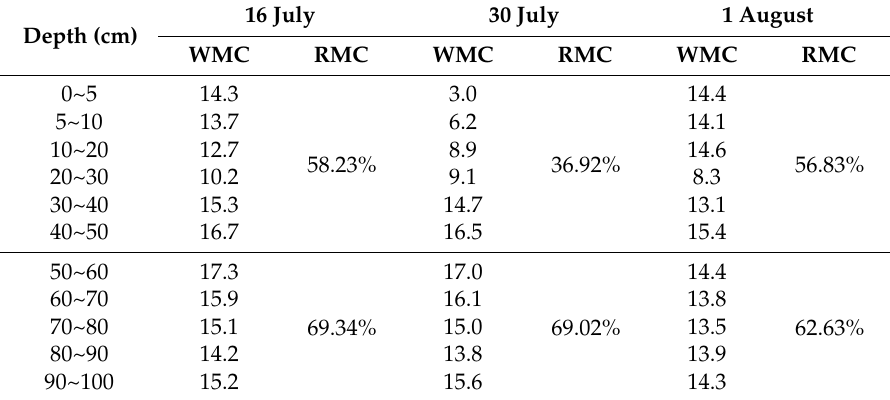
Table 2. Weight moisture capacity (WMC) and relative moisture content (RMC) at different depths (Irrigation was carried out on the nights of 14 July and 30 July).